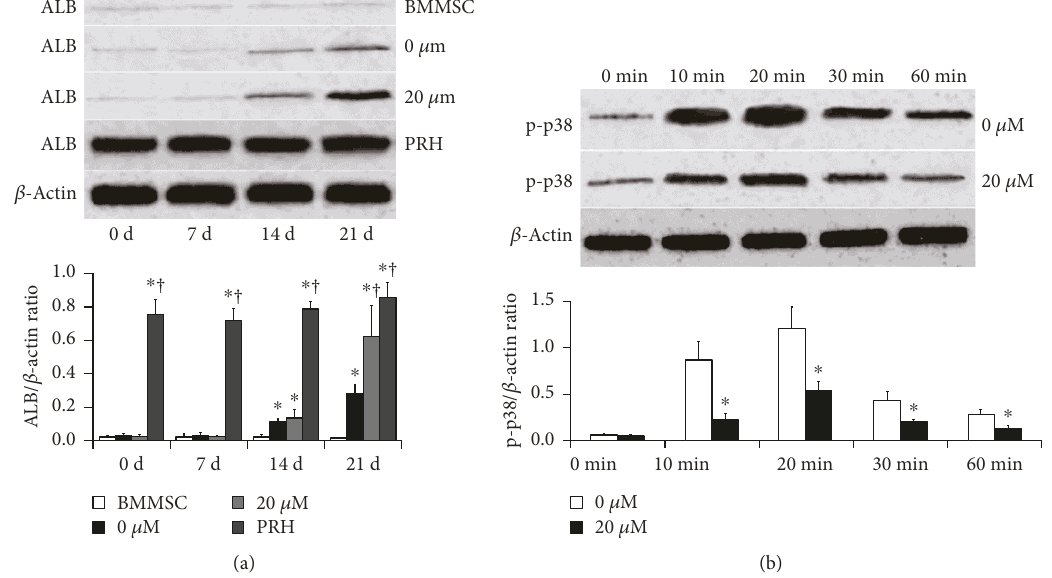
Figure 3: Zebularine promoted protein expression of ALB in BMMSCs and attenuated activation of the p38 signal pathway induced by HGF. (a) The protein expression of ALB increased on day 14 and reached a peak on day 21 in the 0 μ M (HGF only) group. Zebularine at 20 μ M clearly reinforced the HGF-induced upregulation of ALB protein expression. However, the peak of expression of ALB in both 0 and 20 μ M groups was lower than that in primary rabbit hepatocytes. (b) HGF (0 μ M group) increased the expression of phosphorylated p38 in cultured BMMSCs. However, addition of zebularine (20 μ M group) signi fi cantly suppressed p38 pathway activation in the cells stimulated with HGF. Asterisk indicates p < 0 05 compared with min 0; dagger indicates p < 0 05 compared with HGF (0 μ M